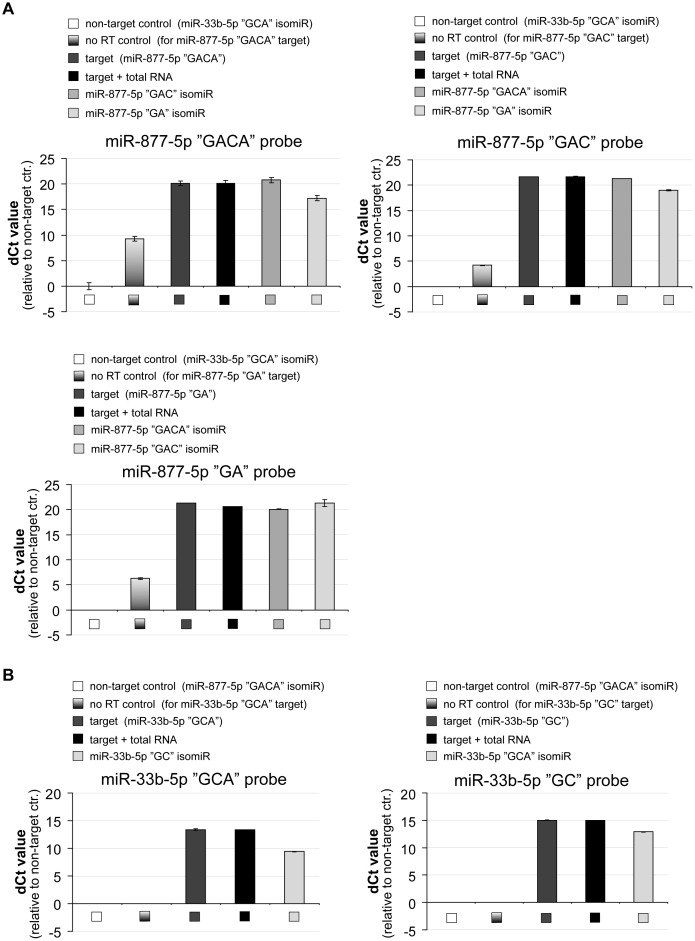
3′ isomiR species may not be distinguished by the stem-loop qRT-PCR.Detection of the 3′ isomiRs of miR-877-5p (A) and miR-33b-5p (B) by the corresponding stem-loop assays using synthetic RNA oligonucleotides as templates. Non-target controls were chosen as reference samples. (Ct values were 36/37/39,6 for the “GACA”/“GAC”/”GA” miR-877-5p isomiRs respectively, while signals were not detected up to 40 reaction cycles for the miR-33b isomiR assays.) The 3′ isomiRs of a particular miRNA locus are cross-detected using stem-loop qRT-PCR, although the extent varies among the different probes. Experiments were carried out at least in four independent measurements. One representative experiment is shown, error bars represent standard deviations.